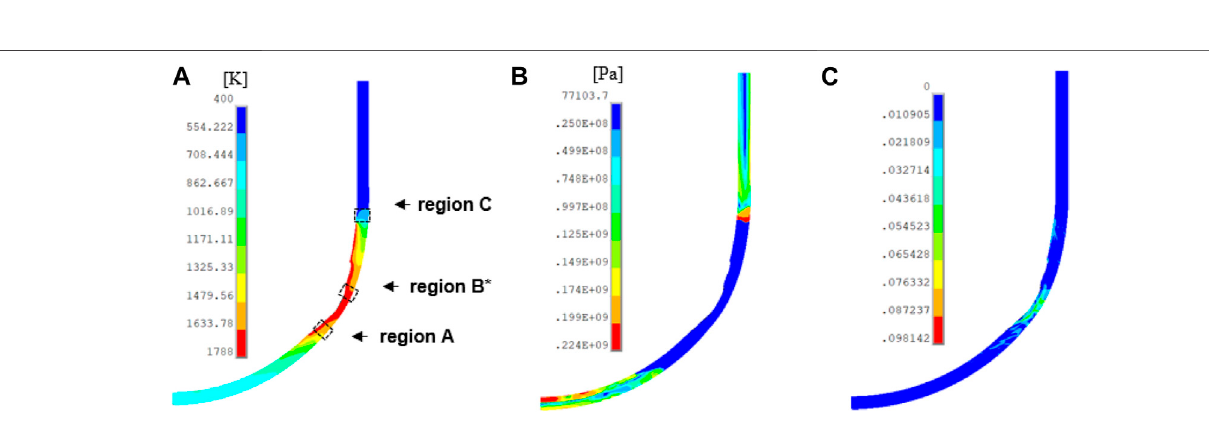
Frontiers in Energy Research |